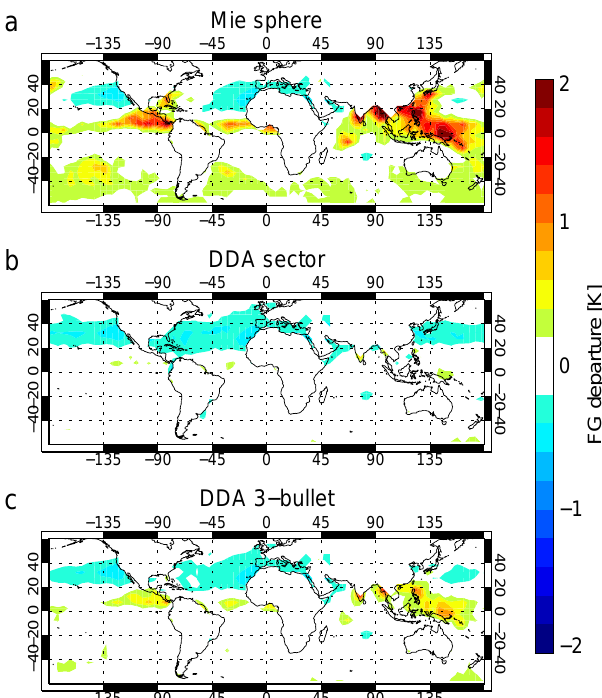
Figure 6. June 2012 mean FG departures in the 52.8GHz channel on SSMIS for three choices of snow optical properties. Means are computed in bins of 5 ◦ by 5 ◦ in latitude and longitude.